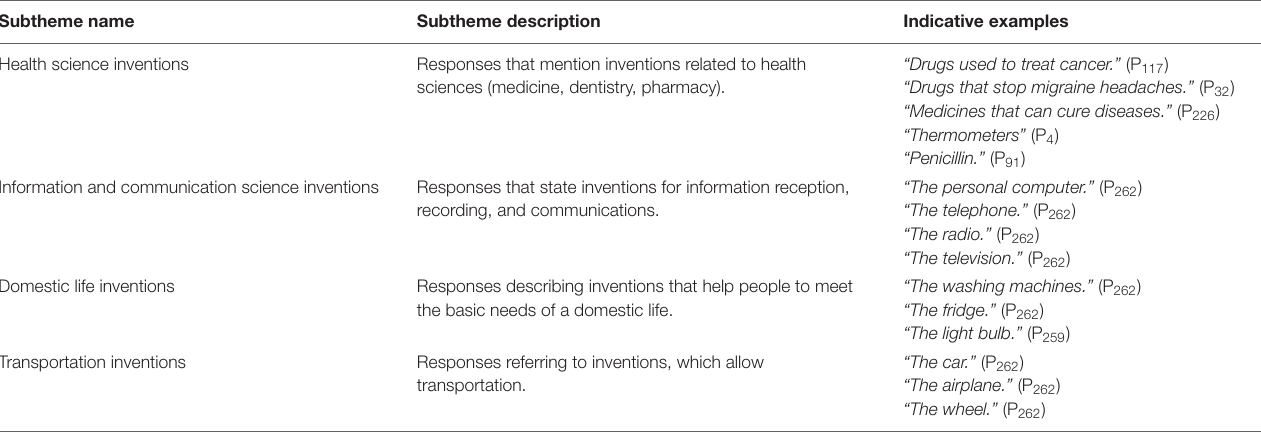
TABLE 3 | Great inventions’ subthemes, their descriptions, and indicative examples.